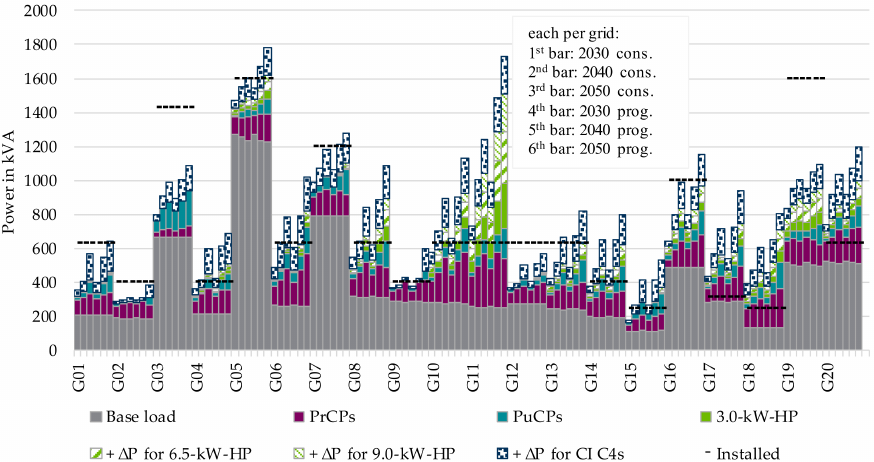
Figure 16. Load development and installed capacity from the perspective of local distribution transformers for 20 low-voltage grids.